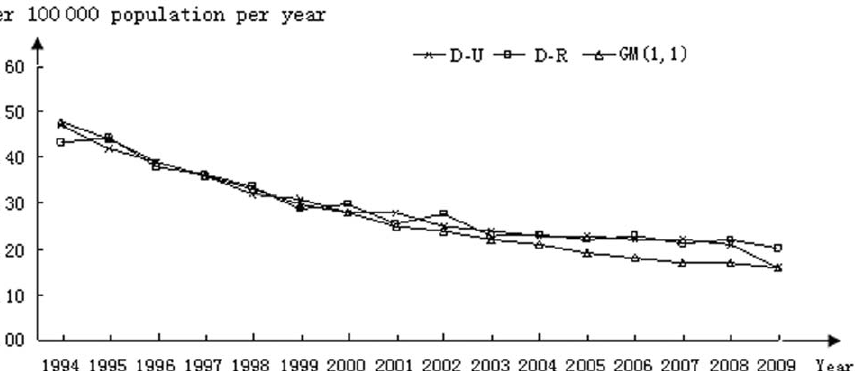
Figure 3. Mortality of HIV-negative TB patients in the US; a comparison between actual (D-U) and calculated datasets using the D-R and GM(1,1) models.